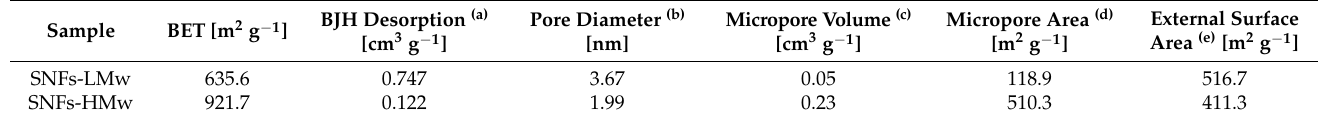
cated the largest surface area (921.7 m 2 g − 1 ) for SNFs-HMw while in SNFs-LMw samples had a lower surface area in comparison (635.6 m 2 g − 1 ), which was indicative of mostly and micropore area were much high for SNFs-HMw than for SNFs-LMw. In contrast, BJH pore volume (0.74 cm 3 g − 1 ) and desorption average pore width of 3.67 nm for SNFs-LMw. For SNFs-HMw those values are 0.12 cm 3 g − 1 and 1.99 nm, respectively (Table 2). Table 2. Physical parameters of SNFs-LMw and